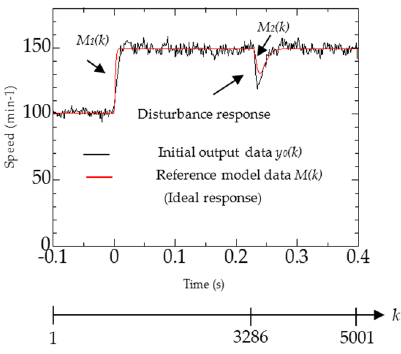
Figure 8. Output data using the initial PI ‐ P gain controller and reference model data.